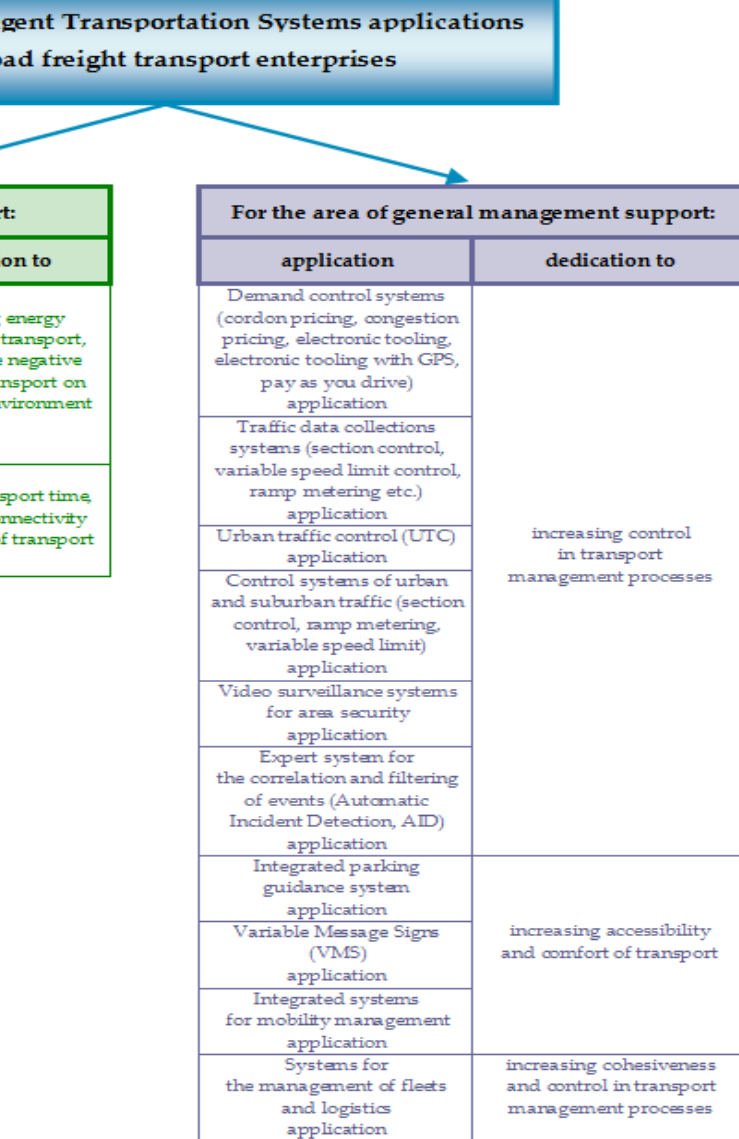
Figure 1. Selected ITS applications dedicated to vehicle support and general management in road freight transport enterprises. Source: own elaboration based on: [28,29].